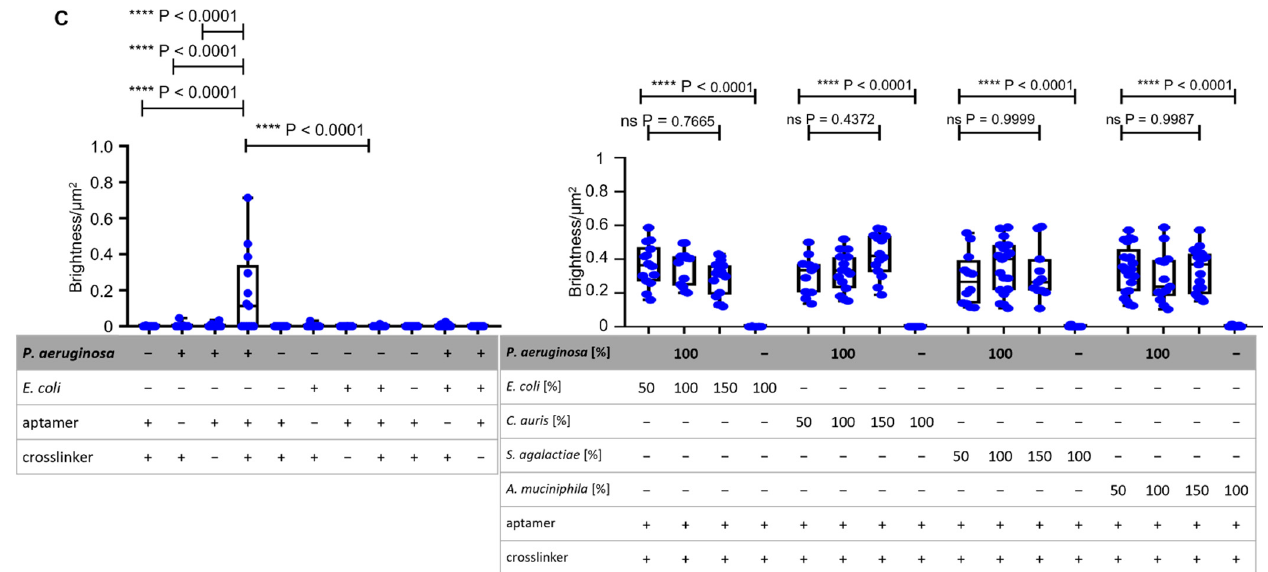
Figure 5. Compatibility of non-functionalized and fully functionalized BSA hydrogel beads and specific binding analysis with BSFA of ACBs in human serum and sheep blood. ( A ) Determination of sheep blood hemolysis with non-functionalized and fully functionalized hydrogel beads with absorption measurement at 450 nm. The detergent Triton ® X-100 acted as a positive reference, while DPBS acted as a negative reference [26]. ( B ) BSF analysis of ACBs in human serum with statistically analyzed unpaired t-tests with Welch’s correction between incomplete and fully functionalized ACBs with GFP-labeled P. aeruginosa and E. coli cells. For the setups of P. aeruginosa with different ratios of non-binding E. coli , C. auris , S. agalactiae , and A. muciniphila , the Brown–Forsythe ANOVA showed no significant p -values for all ratios (all p < 0.9893). ( C ) BSF analysis with statistically determined p -values via unpaired t-test with Welch’s correction of the specific binding of ACBs with P. aeruginosa and E. coli cells in sheep blood. Statistical analysis of the setups of different ratios of non-binding control strains mixed with P. aeruginosa was performed using a Brown–Forsythe ANOVA and shows no significant p -values (all p < 0.4372).